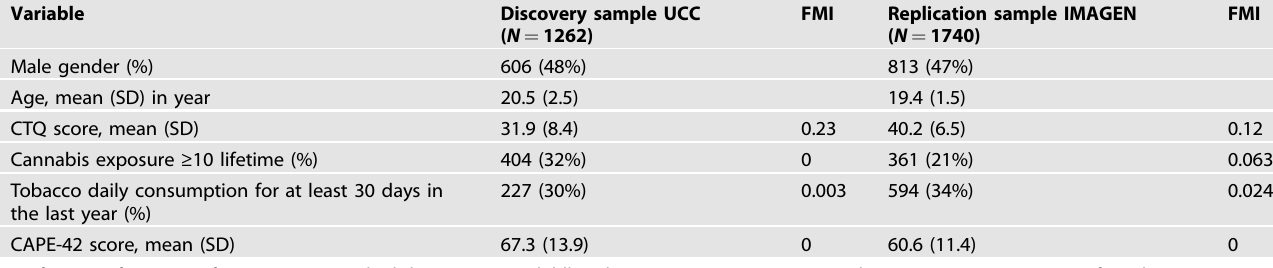
Table 1. Characteristics of the discovery sample and the replication